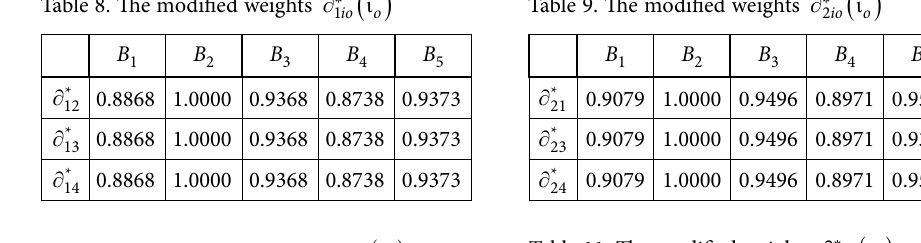
Table 11. The modified